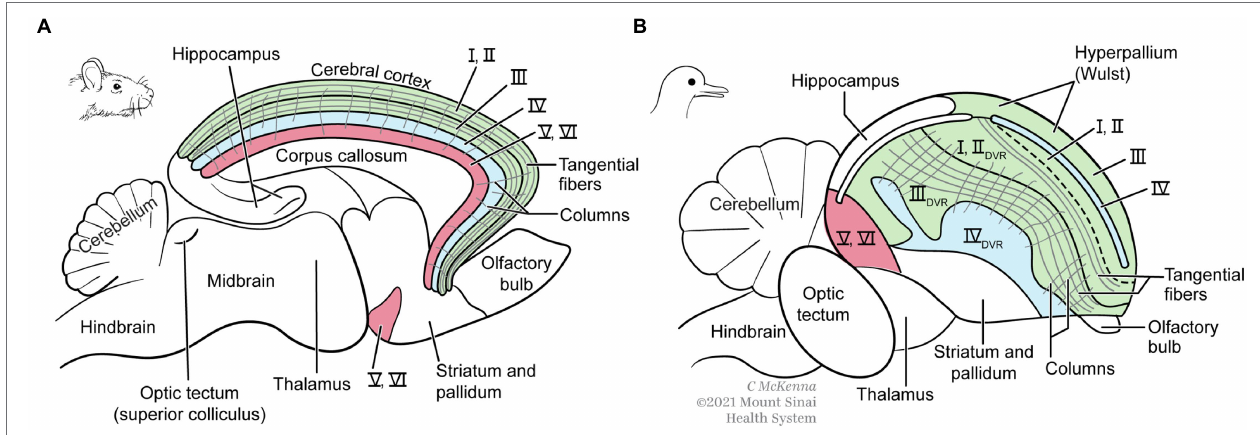
FIGURE 9 | Finer structure of mammal (A) and bird (B) cerebrums. The mammal brain is cut in half in the sagittal midline. Whereas the mammal neocortex has six thin layers of neurons (I–VI), the analogous structures in birds are thicker and distributed more widely including in the DVR, which mammals lack. Both brains, however, have comparable columns of radially oriented fibers and groups of tangentially oriented fibers. Modified from Figure 6.9 in Feinberg and Mallatt (2016). The images are reproduced with the permission of the copyright holder Mount Sinai Health